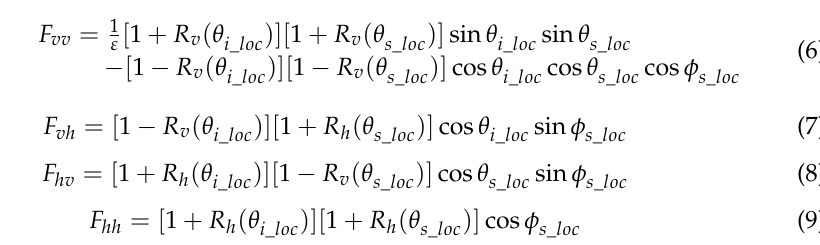
Figure 1. The diagram of the global and local coordinate system. θ , θ represent the incident and scattered angle, and Let _ _ s loc i loc the scattered azimuth angle in the local coordinate system. The scattering polarization factors of each sea surface facet in the global coordinate system can be written as [33]